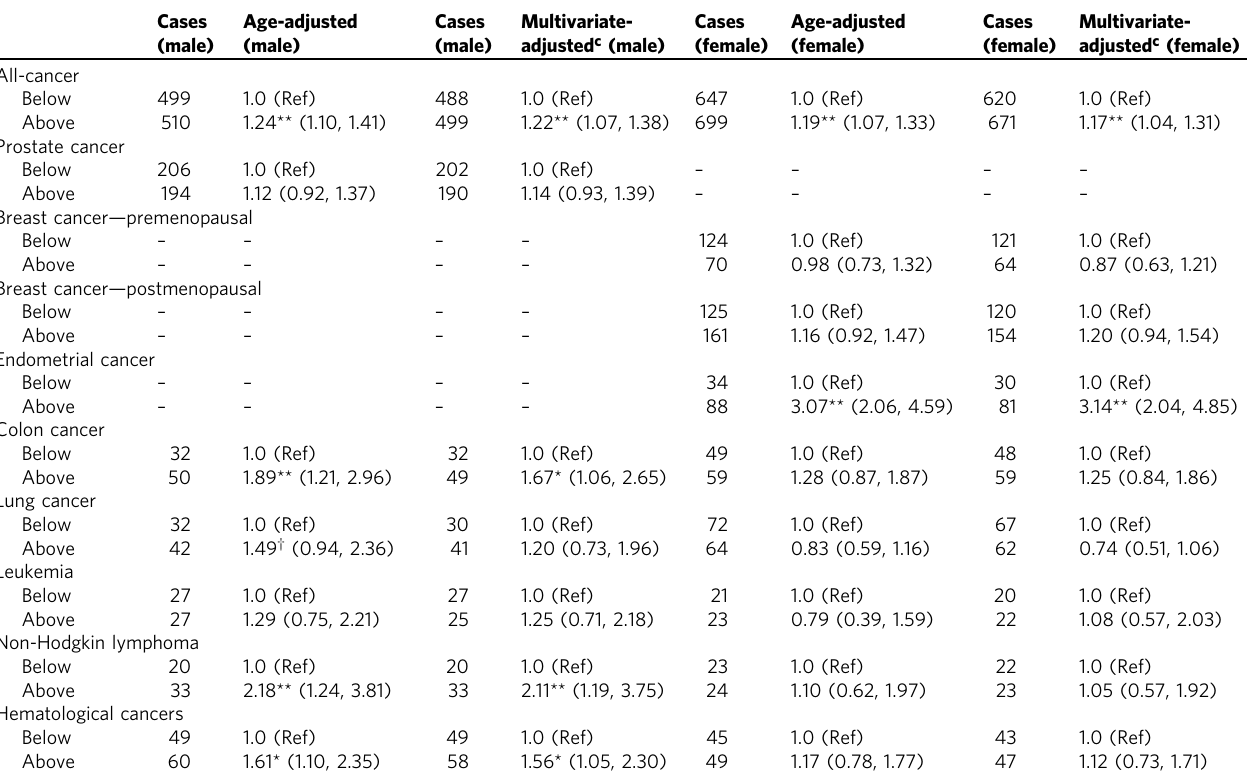
Table 3 Results from analyses of waist circumference a,b and cancer incidence ( n = 26,488) Cases